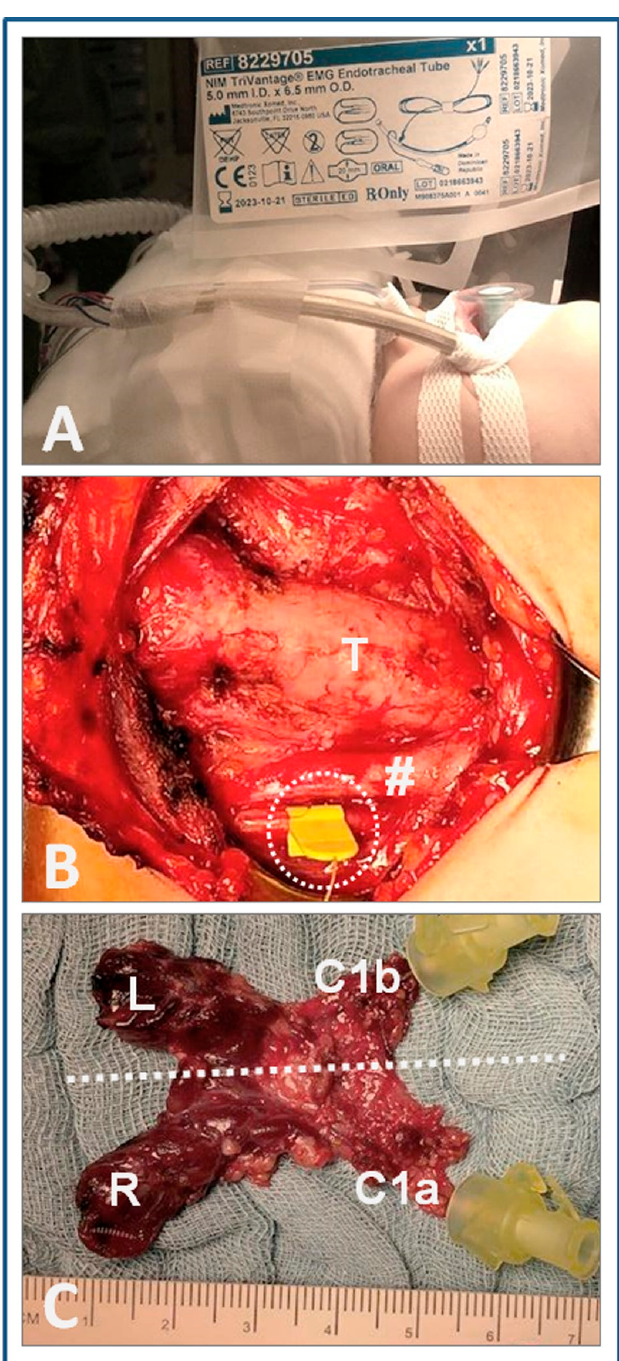
Figure 4. Continuous intraoperative nerve stimulation in a 3.5-year-old girl with C-cell hyperplasia in the context of multiple endocrine neoplasia type 2A. ( A ) Fitted recording endotracheal tube surface electrodes (NIM Trivantage EMG Endotracheal Tube 5.0). ( B ) Intraoperative situs after complete mobilization and removal of thyroid gland and central neck nodes, with the monopolar APS ® clip electrode riding on the right vagus. ( C ) Picture of the contiguous surgical specimen comprising both thyroid lobes and central node compartment. The circle identifies the monopolar APS ® clip electrode; the hashtag the right common carotid artery; and the dashed line the midline; whereas T signifies the trachea; L/R the left/right thyroid lobe; and C1a/C1b the right/left central node compartment. Congruent with other research in the field, this study was limited by the use of two risk-minimization strategies at the same time, visual nerve identification and IONM.